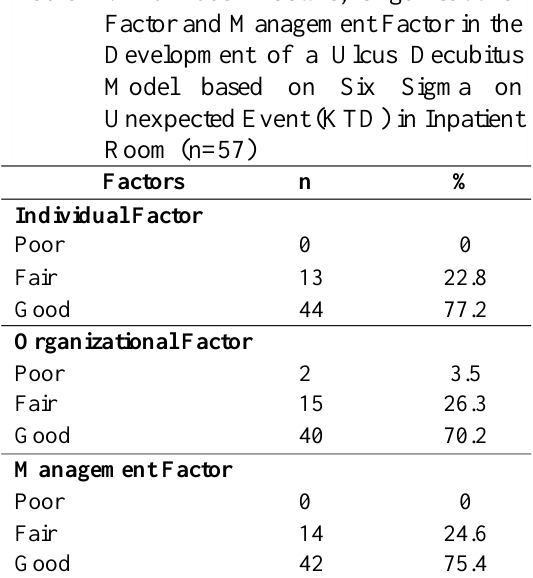
Table 2. Individual Factors, Organisational Factor and Management Factor in the